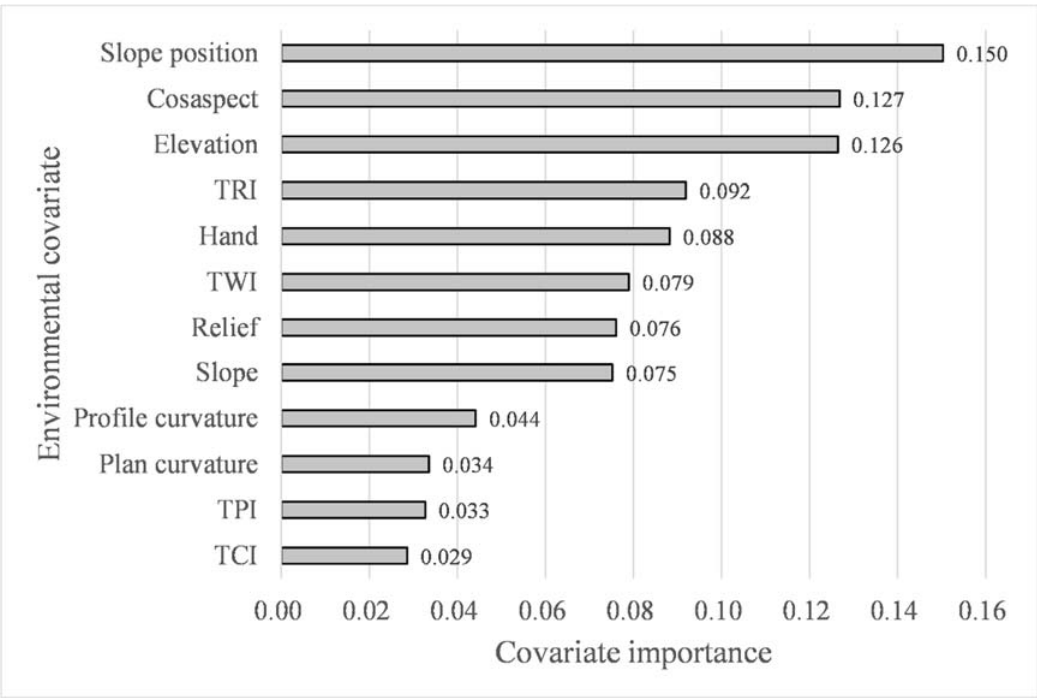
Figure 4. The results of importance measure for the environmental covariates selection.